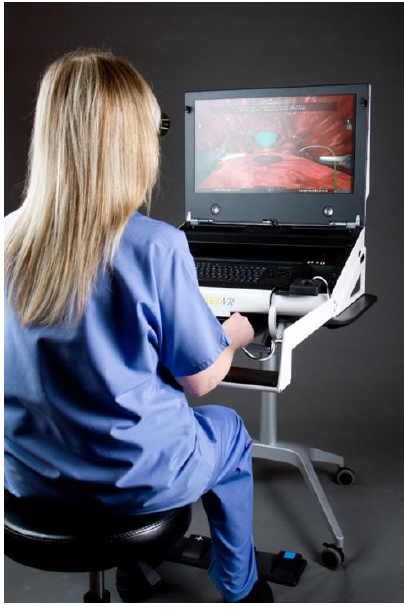
Figure 1. Mimic Flex VR TM in use (obtained with the kind permission of Mimic Simulation).